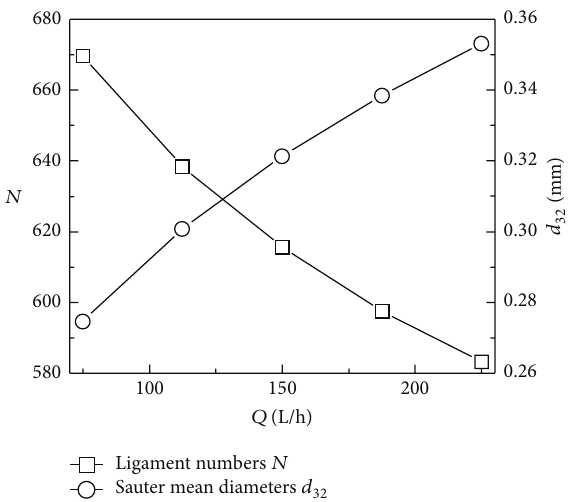
Figure 15: Variation in ligament number and droplet SMD with oil flow rate.